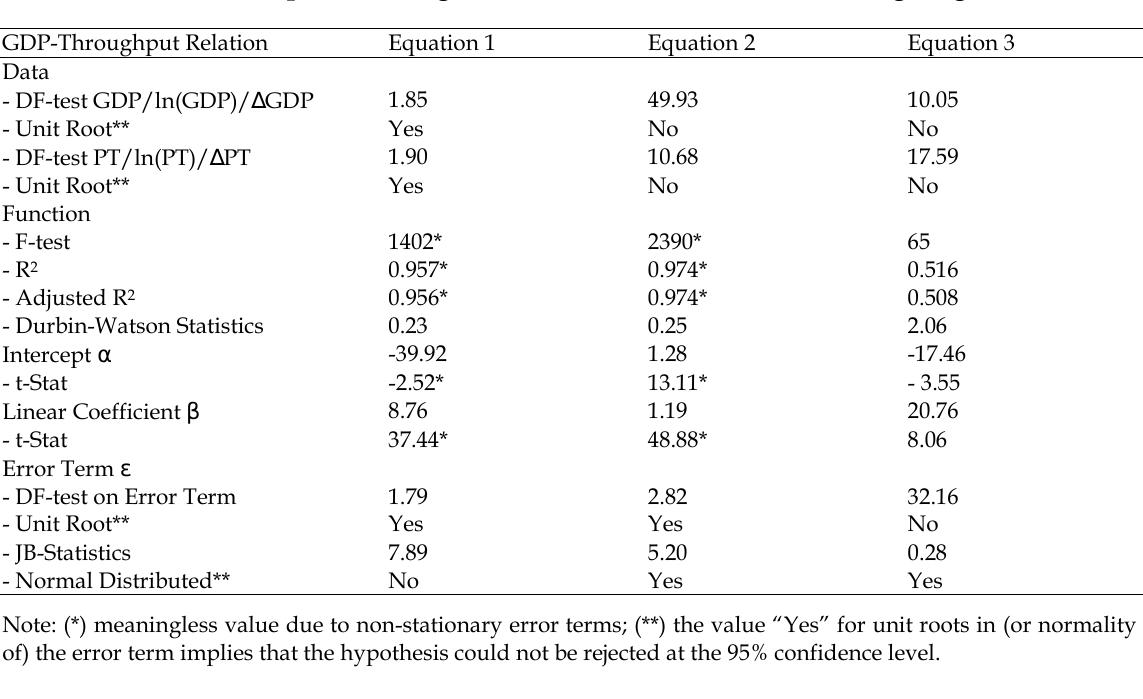
Table 2. Historic development of cargo volumes in the Le Havre – Hamburg range